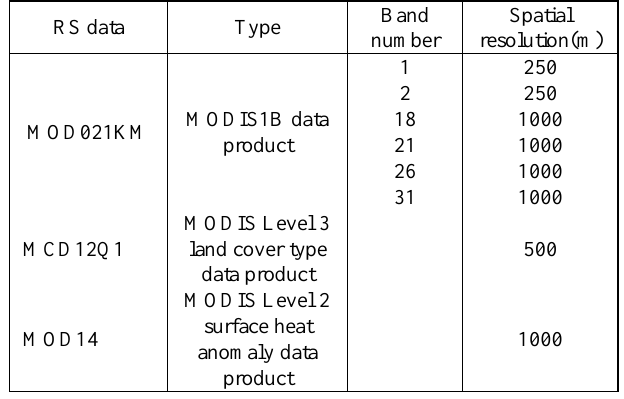
Table 1 . Specific information about the RS data.